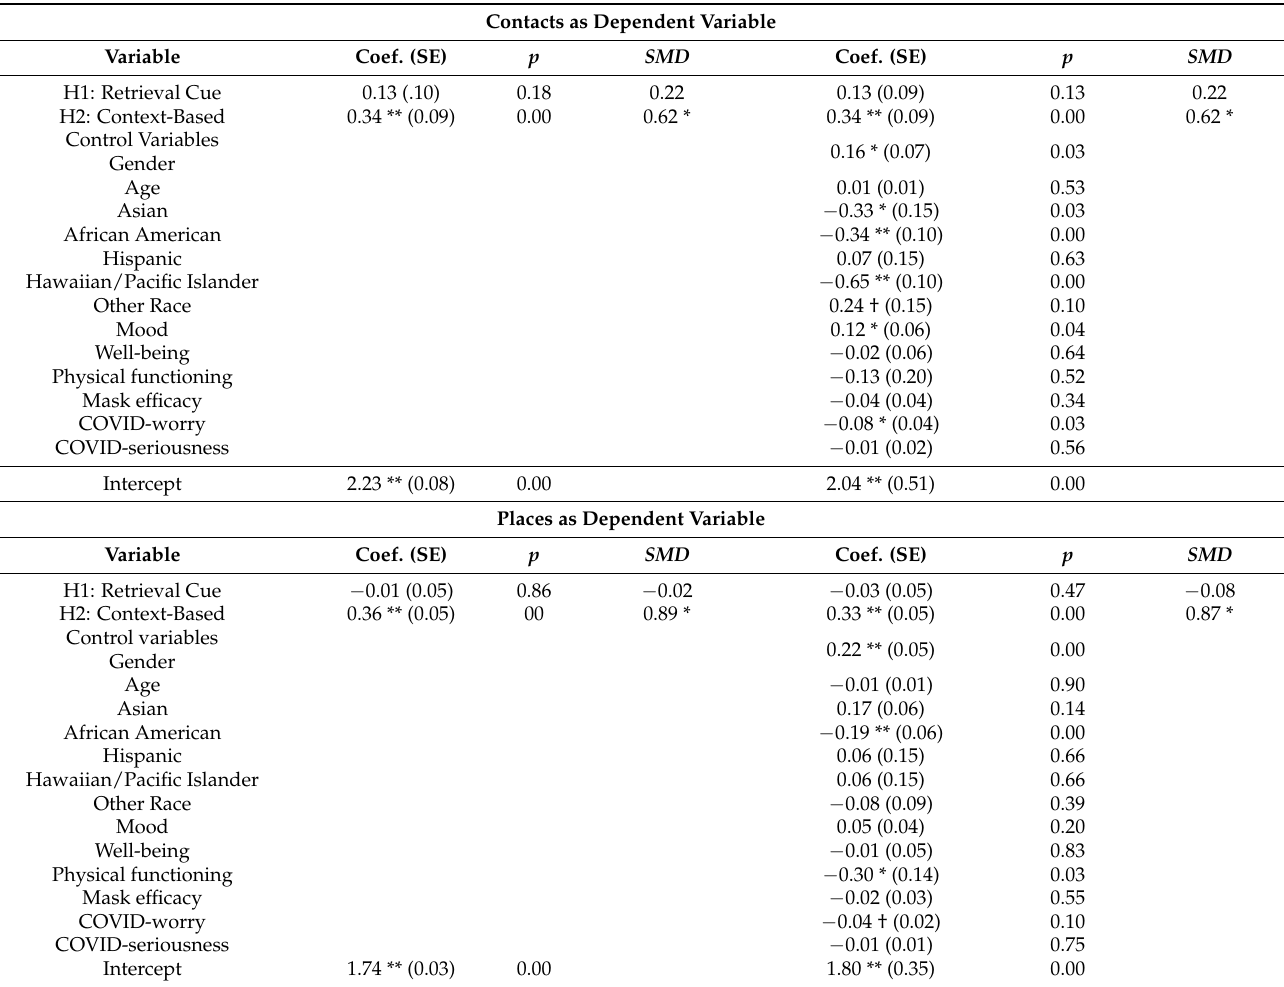
Table 2. Robust negative binomial